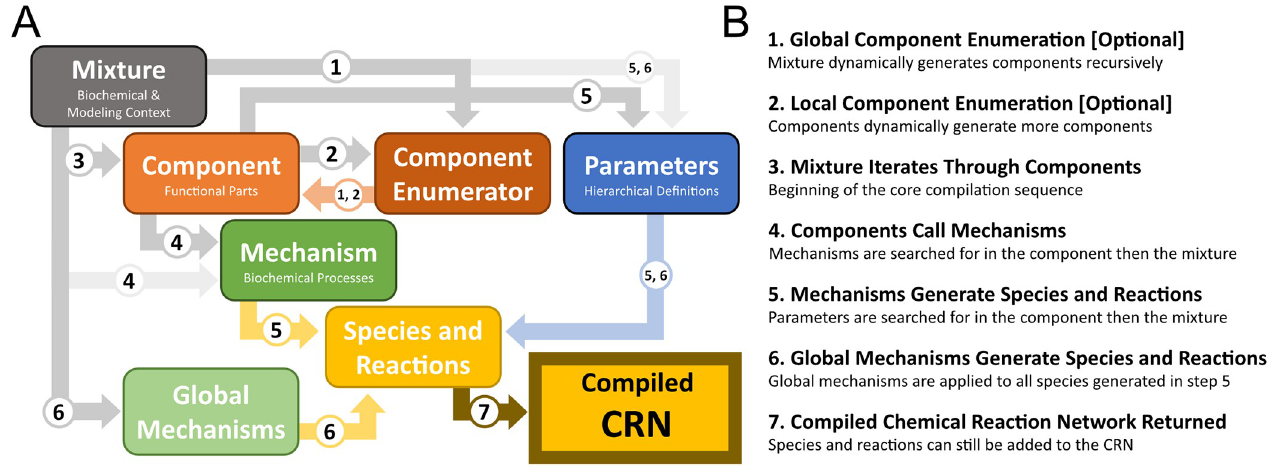
Fig 3. A . the organization of classes in BioCRNpyler. Gray arrows indicate the hierarchical organization of objects (e.g. Components are contained in a Mixture ). Dark gray arrows take precedence over light gray arrows (e.g. a Component will search for Mechanisms in itself before looking at its Mixture ). Colored arrows denote the generate of objects: Components are orange, parameters are blue, and CRN species and reactions are yellow. B . The compilation sequence in BioCRNpyler. The numbers on the arrows in (A) indicate which part of compilation these connections are involved in.